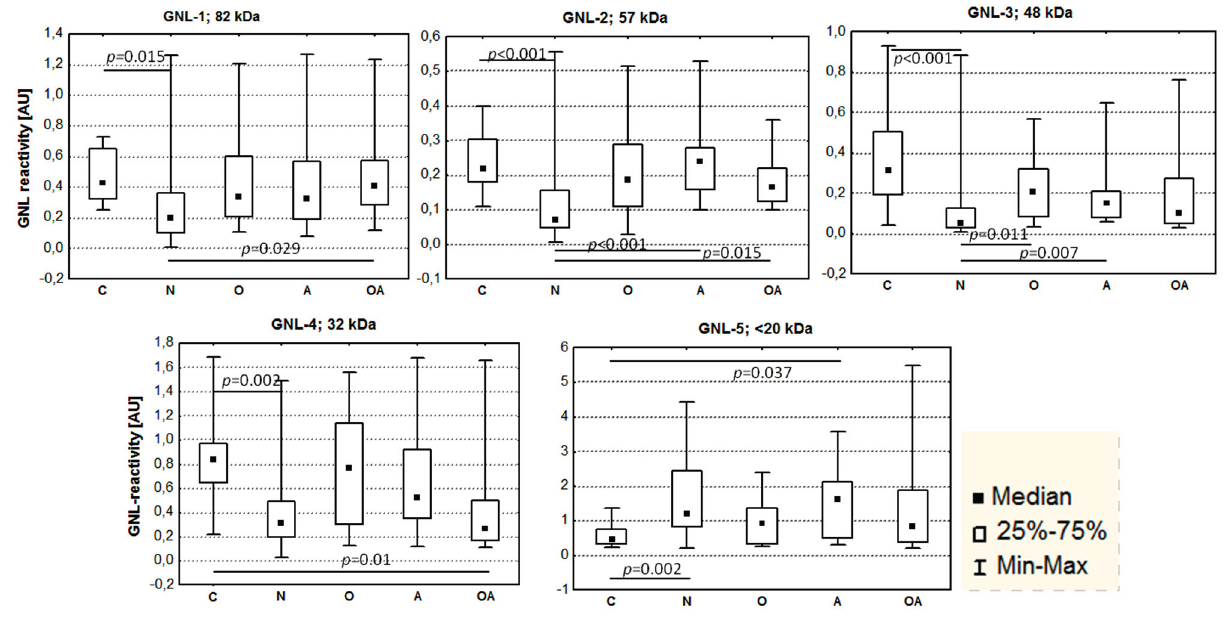
Figure 1. GNL reactivity pattern of seminal plasma glycoproteins. ( A ) Western-blot probed with GNL; ( B ) Sypro Ruby stained gel. Lanes 1–7 and 9–14—individual samples, lane 8—carboxypeptidase Y, lane 15—molecular mass markers.